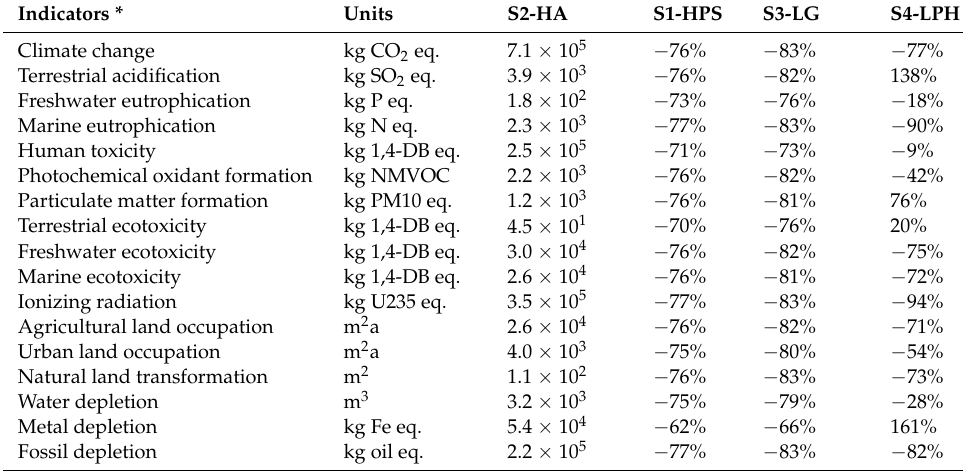
Table 11. Comparative best scenarios: impact mitigation by replacing the HA system. Indicators *